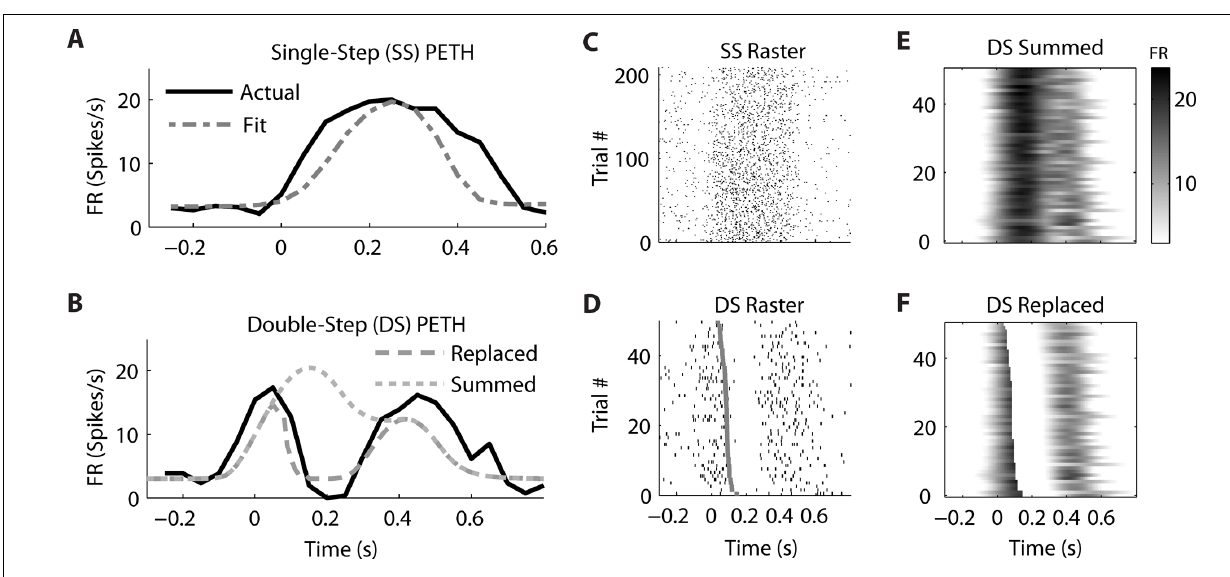
FIGURE 5 |A neuron from ventral premotor cortex is better fit by the “Summed” hypothesis. (A) During single-step (SS) trials, the observed peri-event time histogram (PETH, black) is well fit by a model assuming linear encoding of velocity and speed (gray dot dash). Zero time refers to the time of target appearance. (B) During double-step (DS) trials, the observed PETH (black) is well fit by the “Summed” prediction (gray dotted) but not the